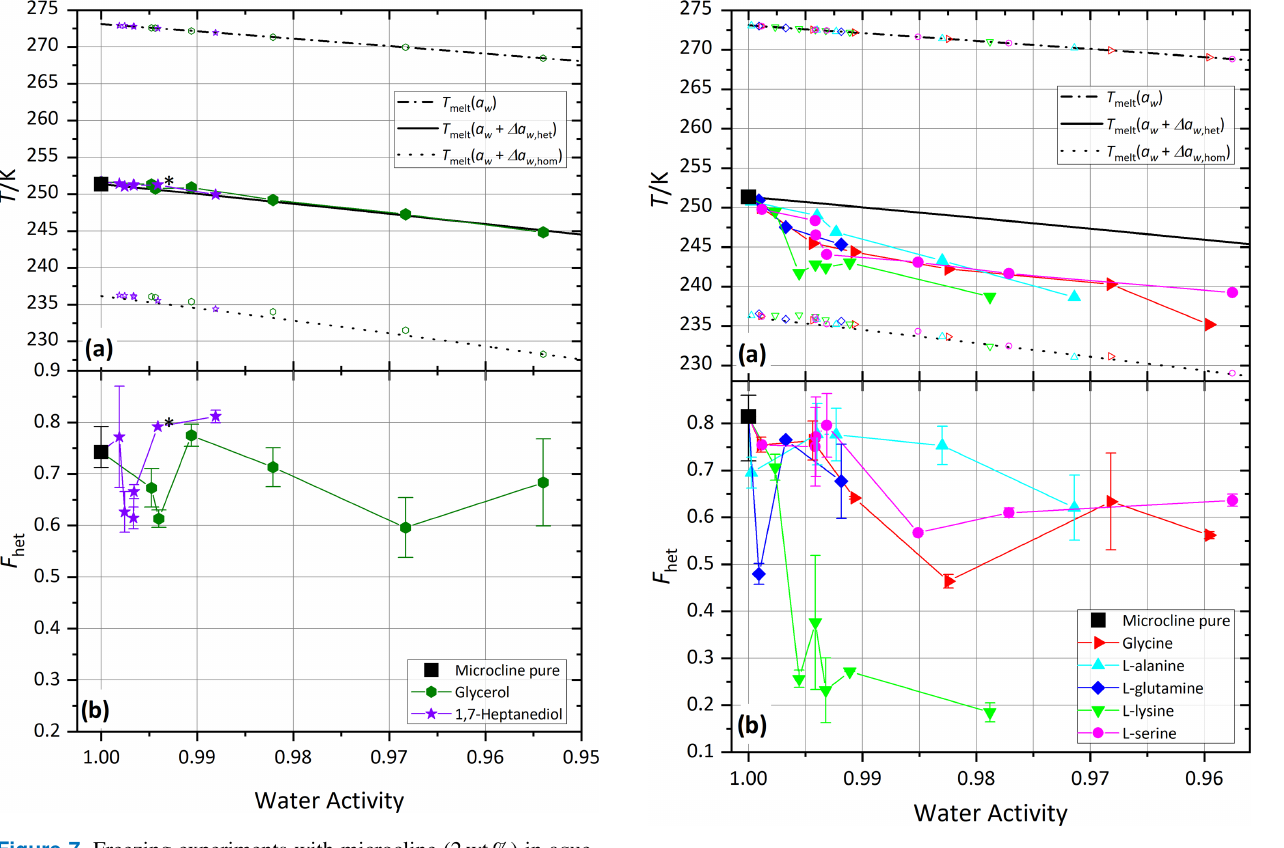
Figure 8. Freezing experiments with microcline (2wt%) in aque- ous amino acid solutions as a function of water activity. Data points and curves are as explained in Fig.